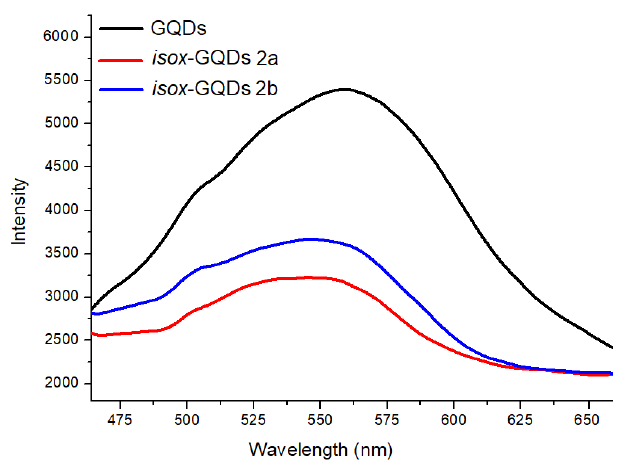
Figure 5. PL spectra of GQDs, isox -GQDs 2a and isox -GQDs 2b , at the λ exc of 360 nm. All samples were tested at a concentration of 100 ng/mL.